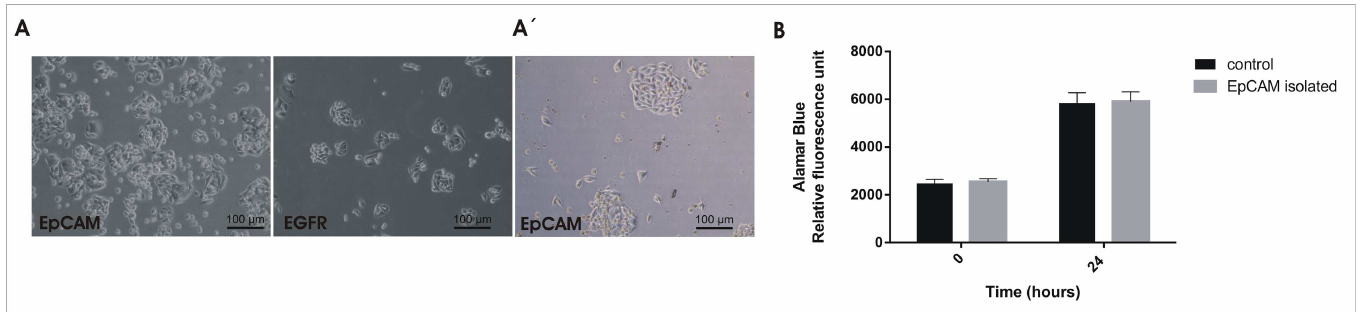
Fig 4. Viability of captured tumour cells. A, A´) Microscopic images of spiked SW480 cells isolated from PBS (A) or healthy donor PBMCs (A´). B) Cell proliferationwas measured by Alamar Blue assay after 24 h in culture. Each point represents the mean ± S.E.M. of 6 replicates per